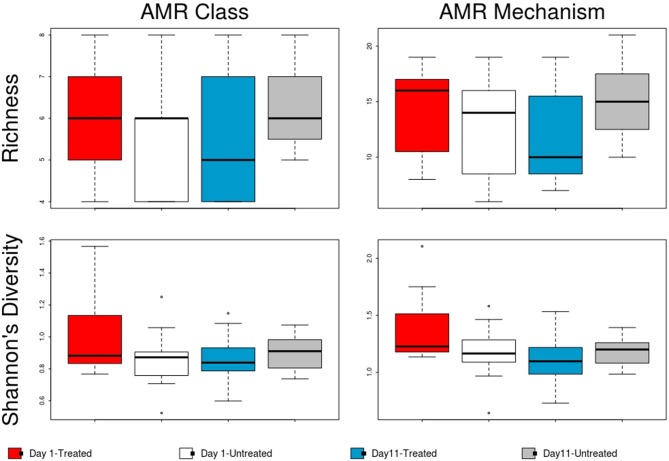
Boxplot of resistome richness and Shannon's diversity at the AMR class and mechanism levels of the two study groups at Day 1 and Day 11. The horizontal line is the median value, the middle box indicates the inter-quantile range, whiskers represent values within 1.5 IQR of the lower and upper quartiles, and individual points show outlier values.